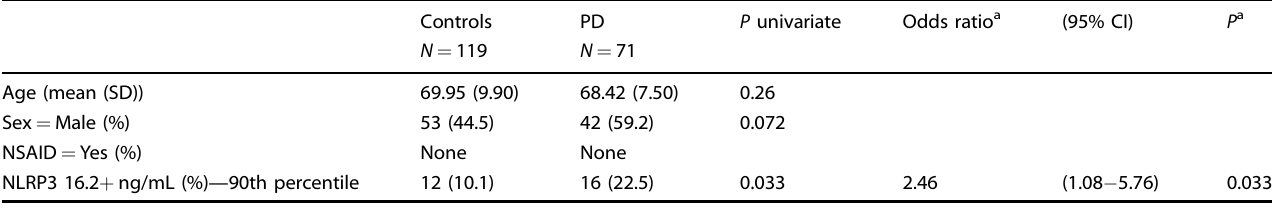
Table 3. Elevated levels of NLRP3 are associated with PD once removing those with self reported NSAID